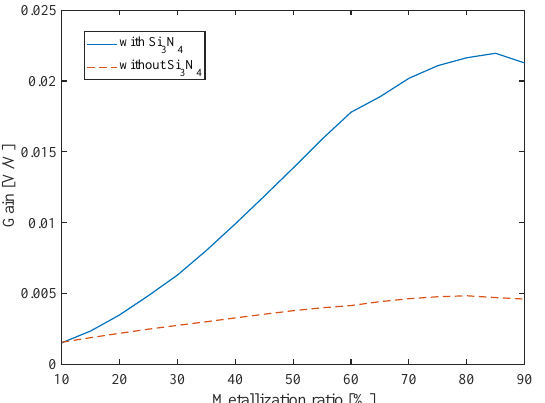
Figure 13. The effect of the Si 3 N 4 layer on the device’s gain for metalization ratios ranging from 10% to 90% operating in mode a.